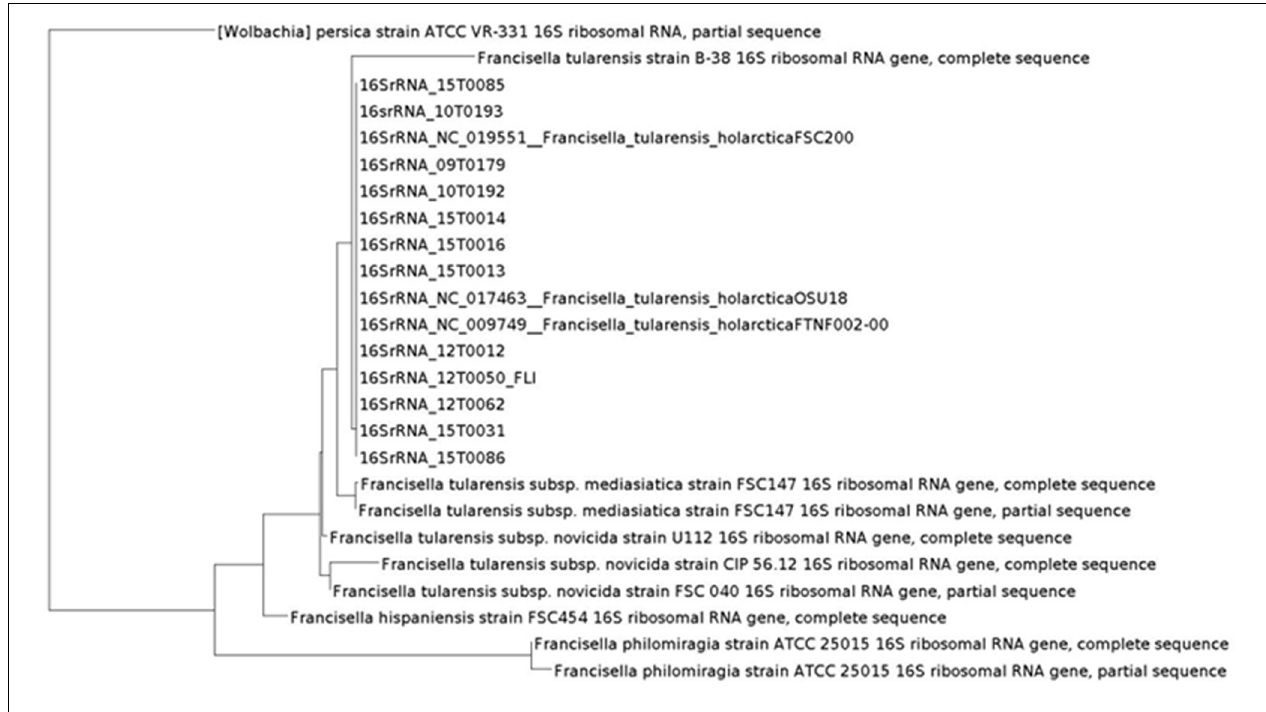
FIGURE 2 | Phylogeny based on 16S rRNA performed with